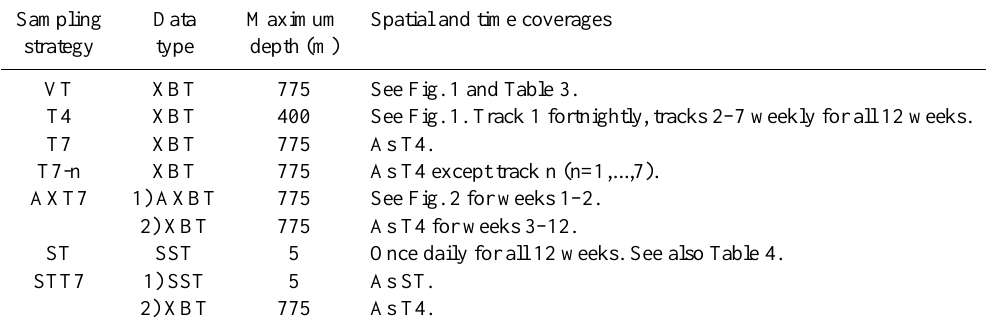
Table 2. Summary of the sampling strategies studied in this work. Experiments with all strategies are performed in summer and winter conditions except VT, studied only in winter Sampling Data Maximum Spatial and time coverages